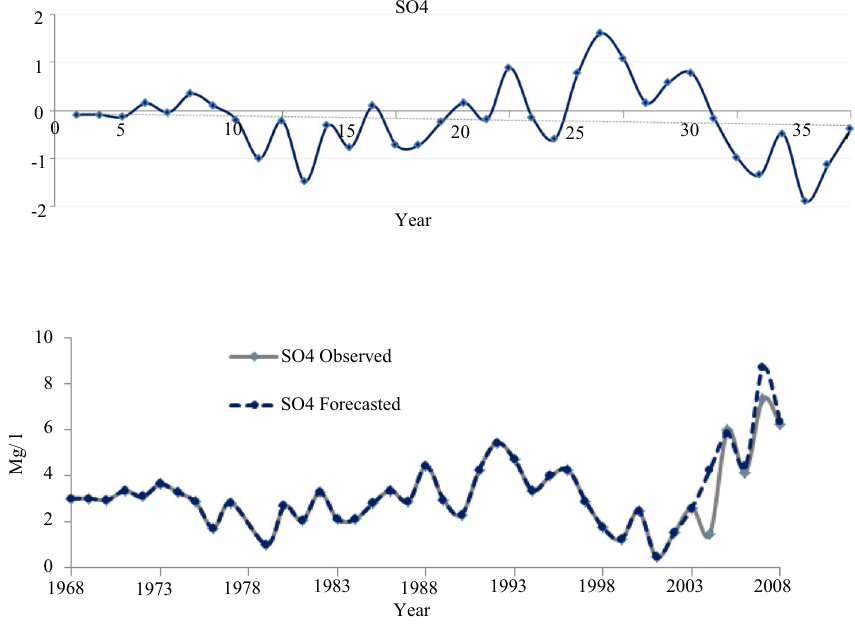
Fig. 6 Uniform time arrange- ment of SO 42− and the assessed values for 5